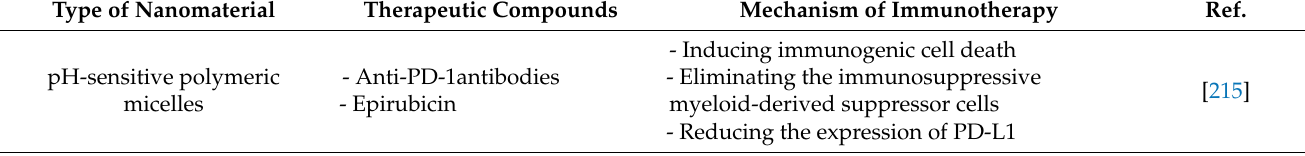
Table 3. Application of nanomaterials for GBM